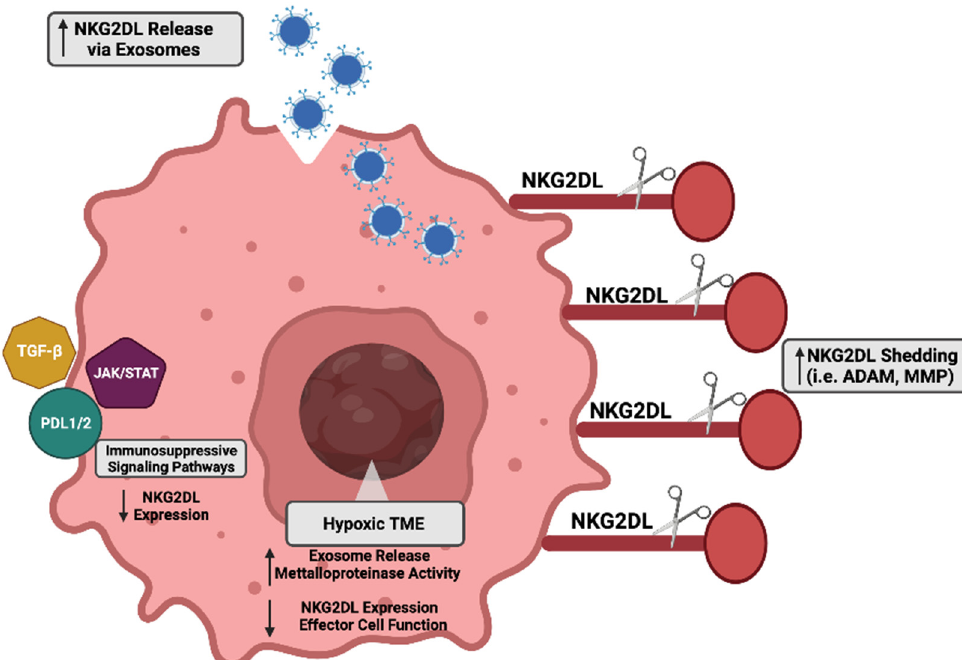
Figure 3. Repression mechanisms of NKG2D ligands in cancer. Multiple mechanisms have been identified in cancer cells to evade immune cell recognition. Generation and release of NKG2D ligands into the extracellular space via exosomes is enhanced and stimulated by the hypoxic tumor microenvironment. Similarly, enhanced proteolytic cleavage activity of matrix metalloproteinase (MMP) and a disintegrin and metalloproteinase (ADAM) family members is regulated by the hypoxic tumor microenvironment. Immunosuppressive and inhibitory mediators (Transforming Growth Factor Beta (TGF- β ), Janus Kinase and Signal Transducer and Activator of Transcription (JAK/STAT), and Programmed Death Receptor Ligand 1 and 2 (PDL1/2)) also collectively diminish NKG2D ligand expression by potentiating the immunosuppressive landscape in cancer. Image generated using Biorender.com (accessed on 16 March 2022), licensure certificate available as File S1.